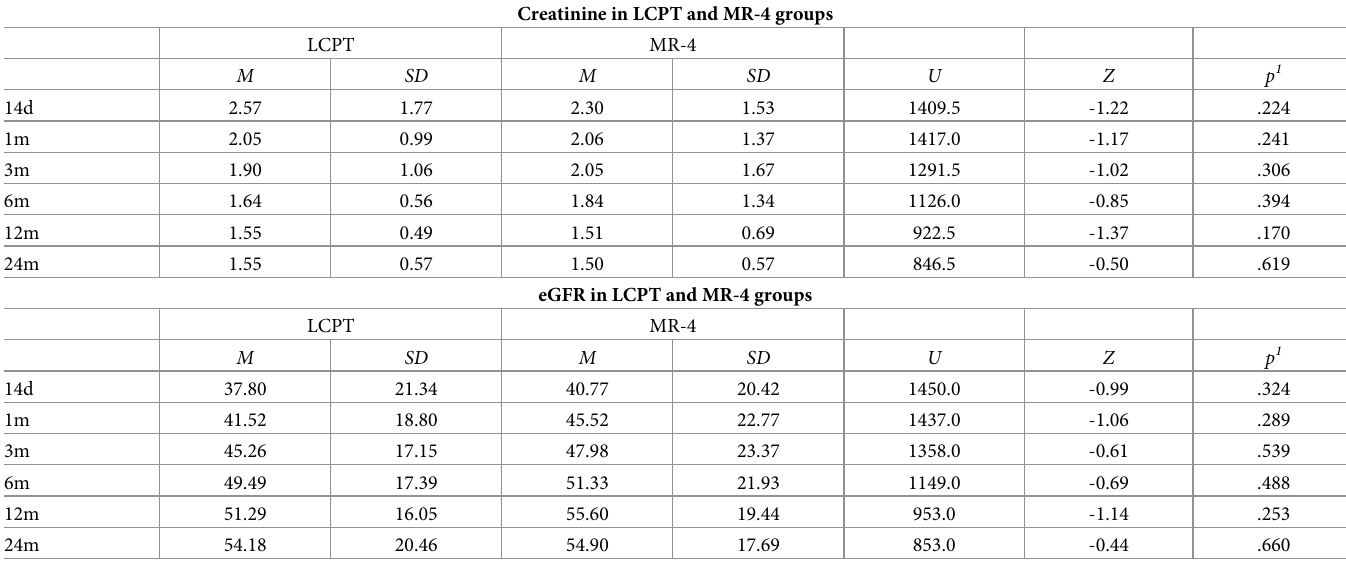
Table 2. Kidney function within 24 months follow-up